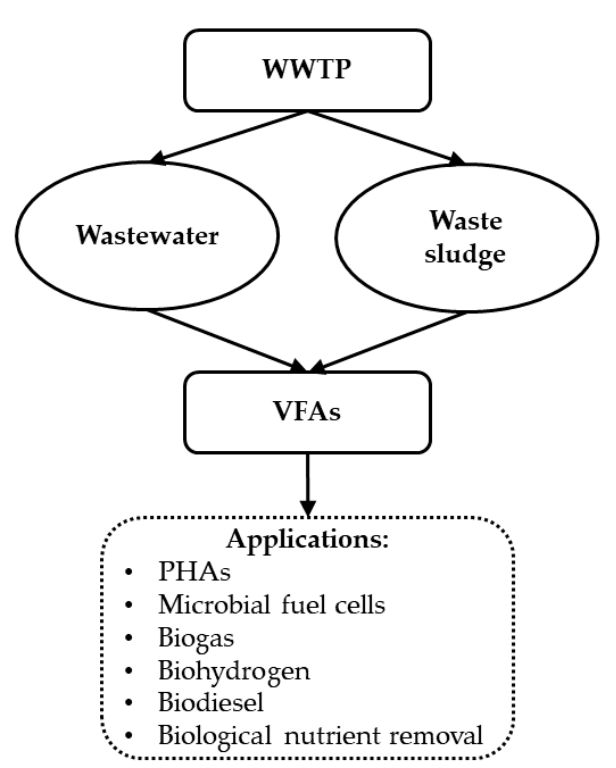
Figure 3. Biorefinery concept overview: volatile fatty acids production and their applications.